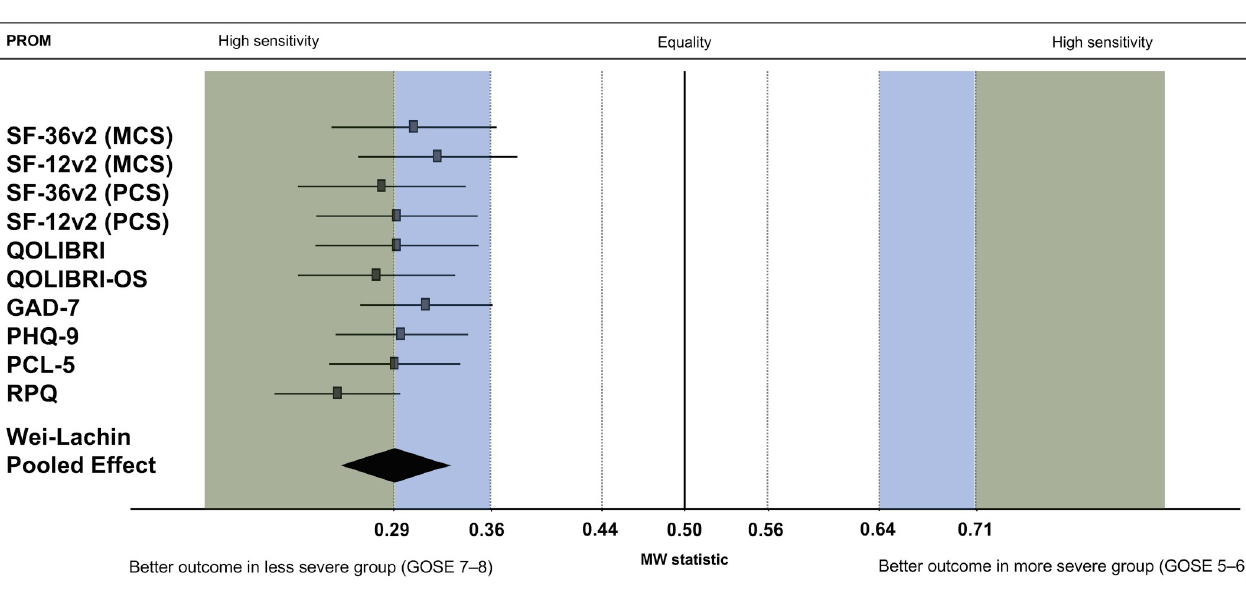
Fig 3. Sensitivity of the PROMs in differentiating between good recovery (GOSE 7–8) and moderate disability (GOSE 5–6) for complicated mild TBI three months post-injury. MW statistic: Mann-Whitney effect size with 95%-CI: confidence interval, Wei-Lachin pooled effect: pooled effect size combined across all PROMs for each group of interest. Green shaded area of the plot: large effect or high sensitivity (MW effect size less than or equal to 0.29 or greater than or equal to 0.71); blue shaded area: medium effect or medium sensitivity (MW effect size beyond 0.36 or 0.64, but greater than 0.29 or less than 0.71); transparent background: small effect or low sensitivity (0.36 � MW �